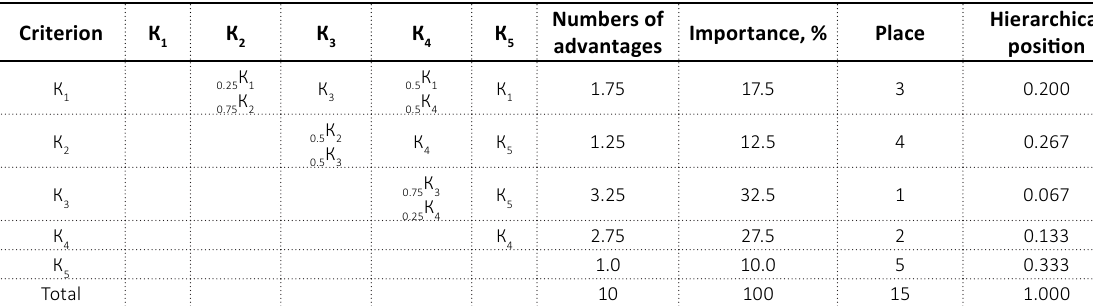
Source: Developed by the authors.